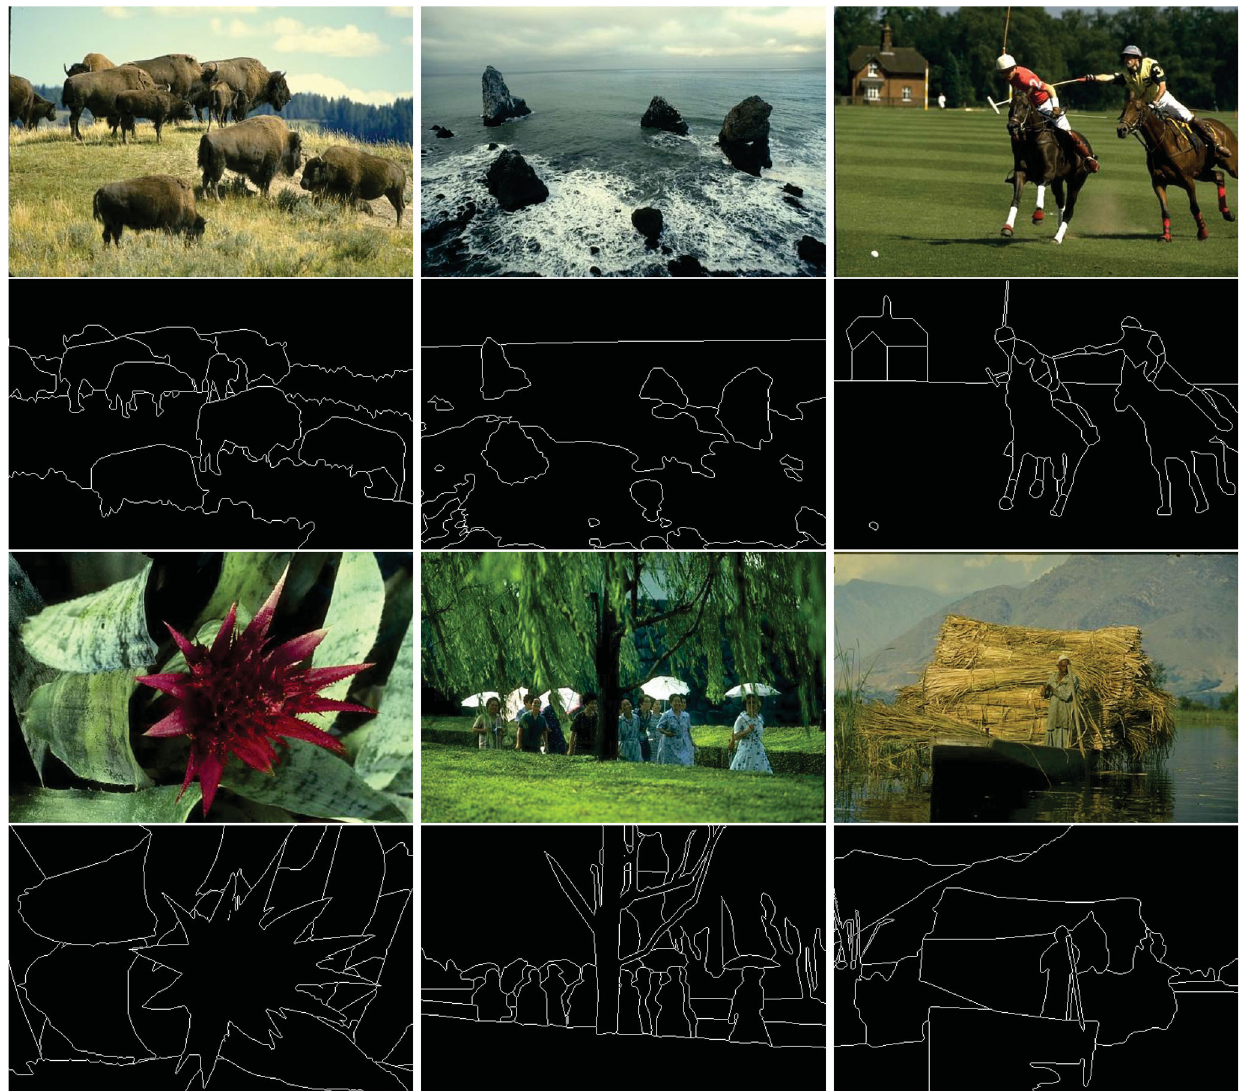
Fig. 3 Images and ground-truths for the BSDS dataset. Rows 1,3: original images. Rows 2,4: corresponding annotated